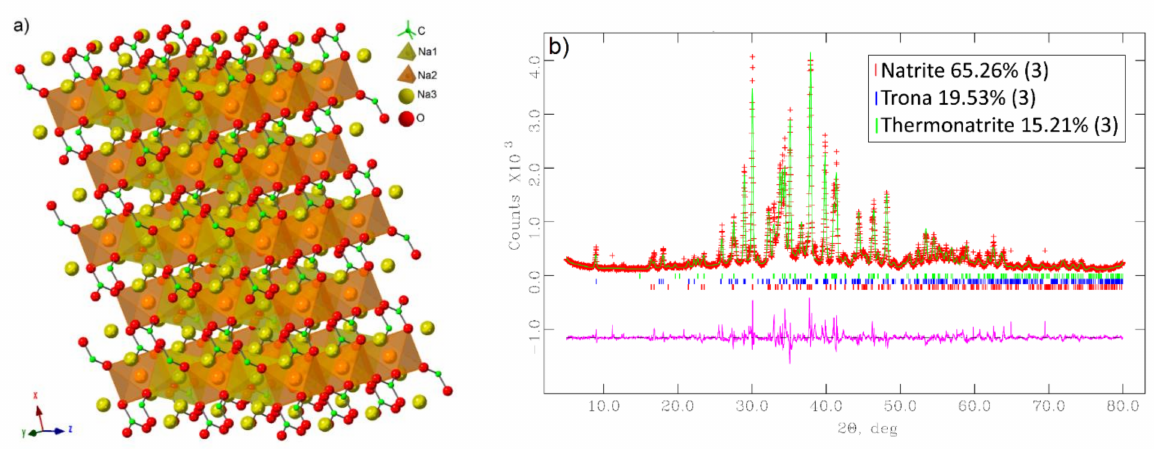
Figure 1. ( a ) Crystal structure of natrite [67]. The sticks represent the C . . . O bonds. ( b ) The X-ray diffraction pattern of the sample defined as natrite collected at room temperature and refined by the Rietveld method [60] with final Rp parameter =